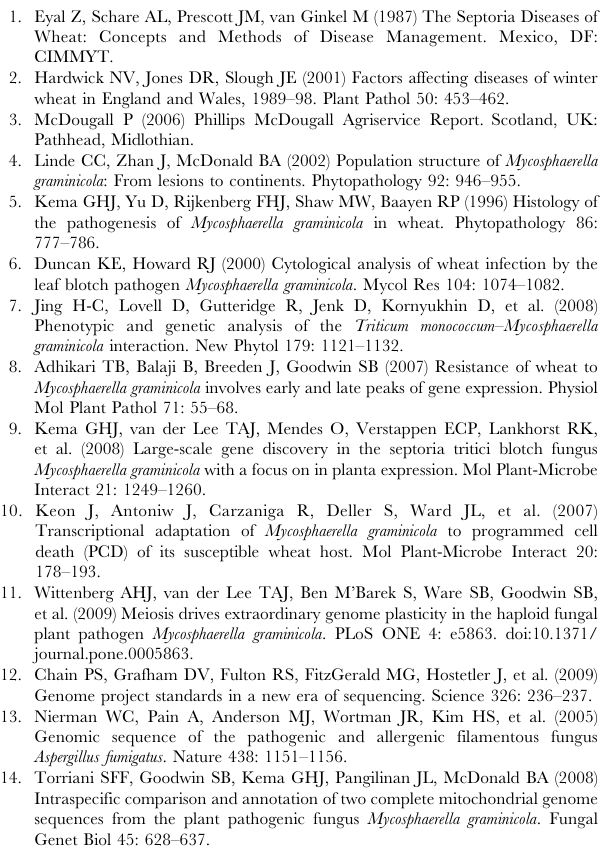
Table S7 PFAM domains that are expanded in the genome of Mycosphaerella graminicola relative to those of five other Ascomyce- tes a but not the two plant-pathogenic Stramenopiles b . Table S8 Assembly statistics for the Mycosphaerella graminicola version 1 (8.9 6 draft) and version 2 (finished) sequences